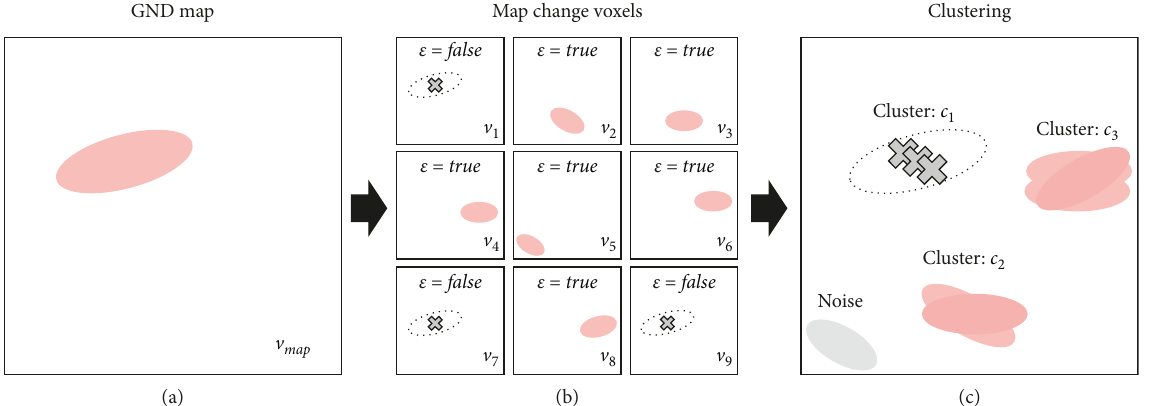
Figure 12: Clustering of map change